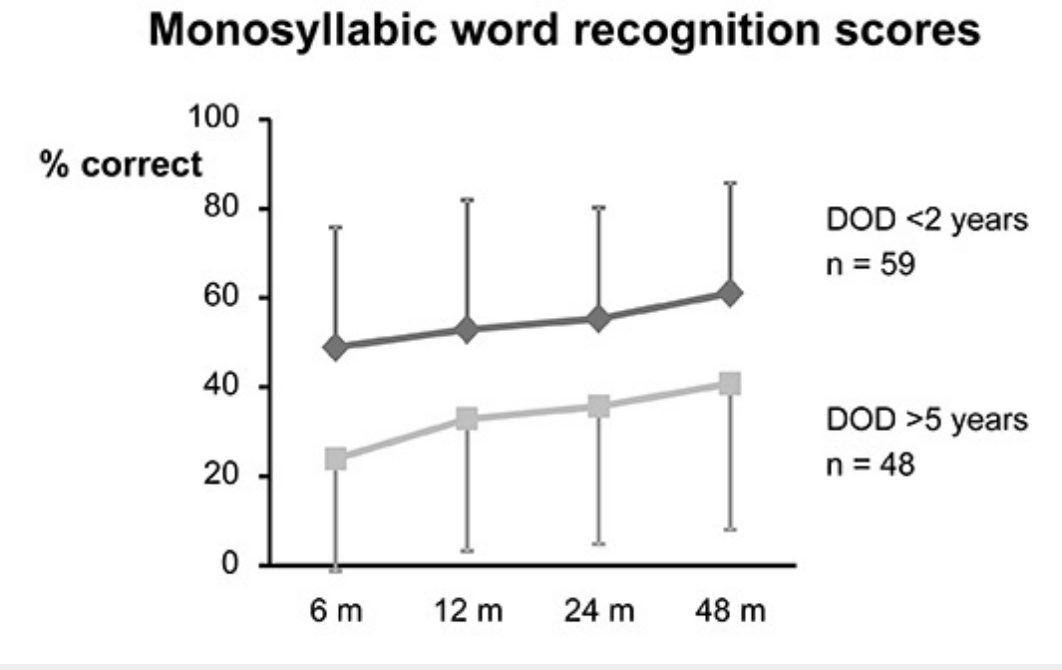
Figure 3 Speech recognition (tested at 80 dB sound pressure level) for the Freiburg monosyllabic test in 107 unilaterally implanted adults over 2 years after implantation. The patients are divided into two groups dependent on duration of deafness (DOD) prior to implantation [23]. Average (±1 standard deviation) monosyllabic word recognition scores are displayed over time after first fitting in months (m) for a group of 59 adult CI patients with a DOD <2 years (average 1.88 ± 1.24 years) and a group of 48 adult CI patients with a DOD of >5 years (16.1 ± 12 years).